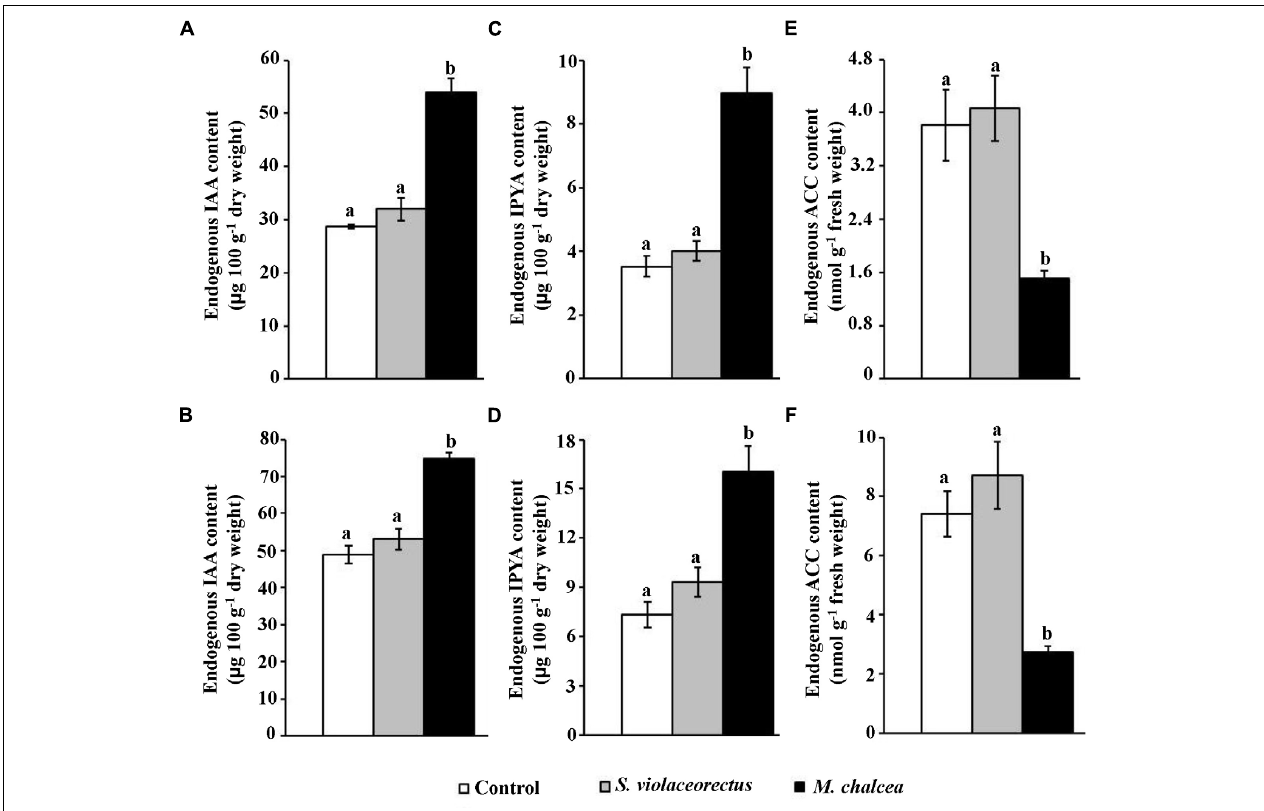
FIGURE 6 | Effect of the application of Micromonospora chalcea UAE1 on endogenous auxins and ACC contents of Salicornia bigelovii plants. Endogenous auxins and ACC content levels of (A,B) IAA; (C,D) IPYA; and (E,F) ACC upon inoculation with autoclaved starch nitrate broth medium (control), ACC deaminase-non-producing isolate ( S. violaceorectus UAE1) or ACC deaminase-producing isolate ( M. chalcea UAE1) of S. bigelovii seedlings. Levels of auxins and ACC contents in (A,C,E) root and (B,D,F) shoot tissues of S. bigelovii seedlings grown in an evaporative-cooled greenhouse and maintained at 25 ± 2 ◦ C at 12 wpt. Seedlings were inoculated using the pruned-root dip method. Values are means of eight replicates ± SE for each sampling from two independent experiments. Mean values followed by different letters are significantly ( P < 0.05) different from each other according to Fisher’s Protected LSD Test. IAA, indole-3-acetic acid; IPYA, indole-3-pyruvic acid; ACC, 1-aminocyclopropane-1-carboxylic acid; wpt, weeks post